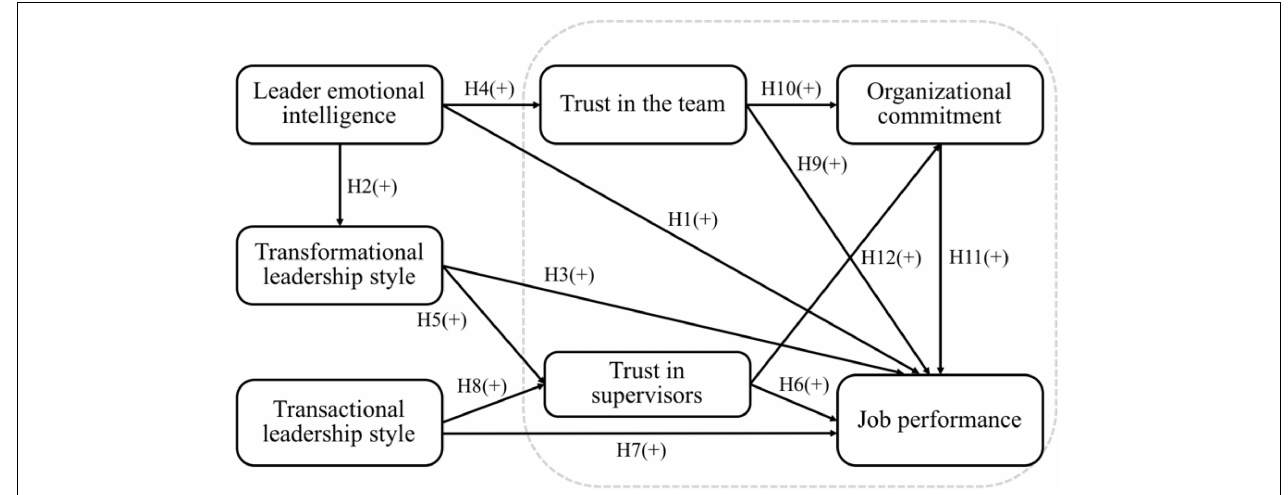
FIGURE 1 | The research framework proposed in this